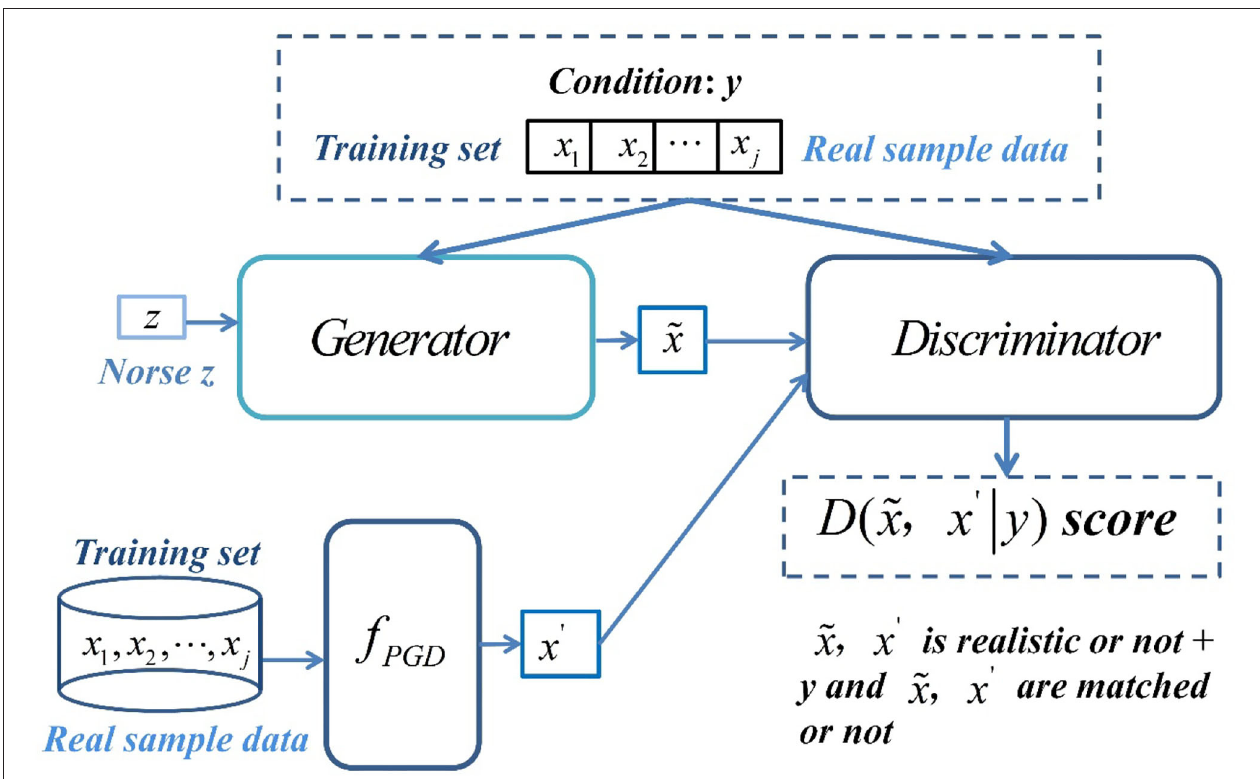
FIGURE 3 | Overall framework of CGAN data enhancement model.